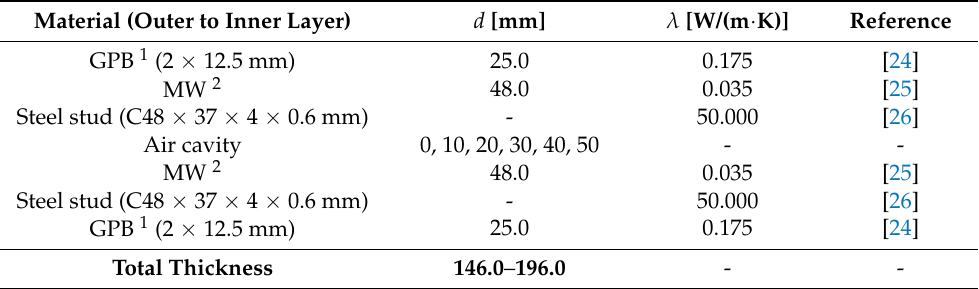
Table 1. Double pane LSF wall materials, thickness ( d ) and thermal conductivities ( λ ).